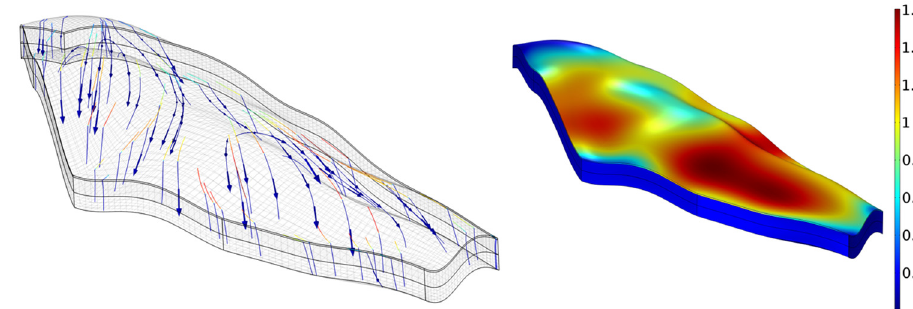
Figure 9. Overall steady flow field.